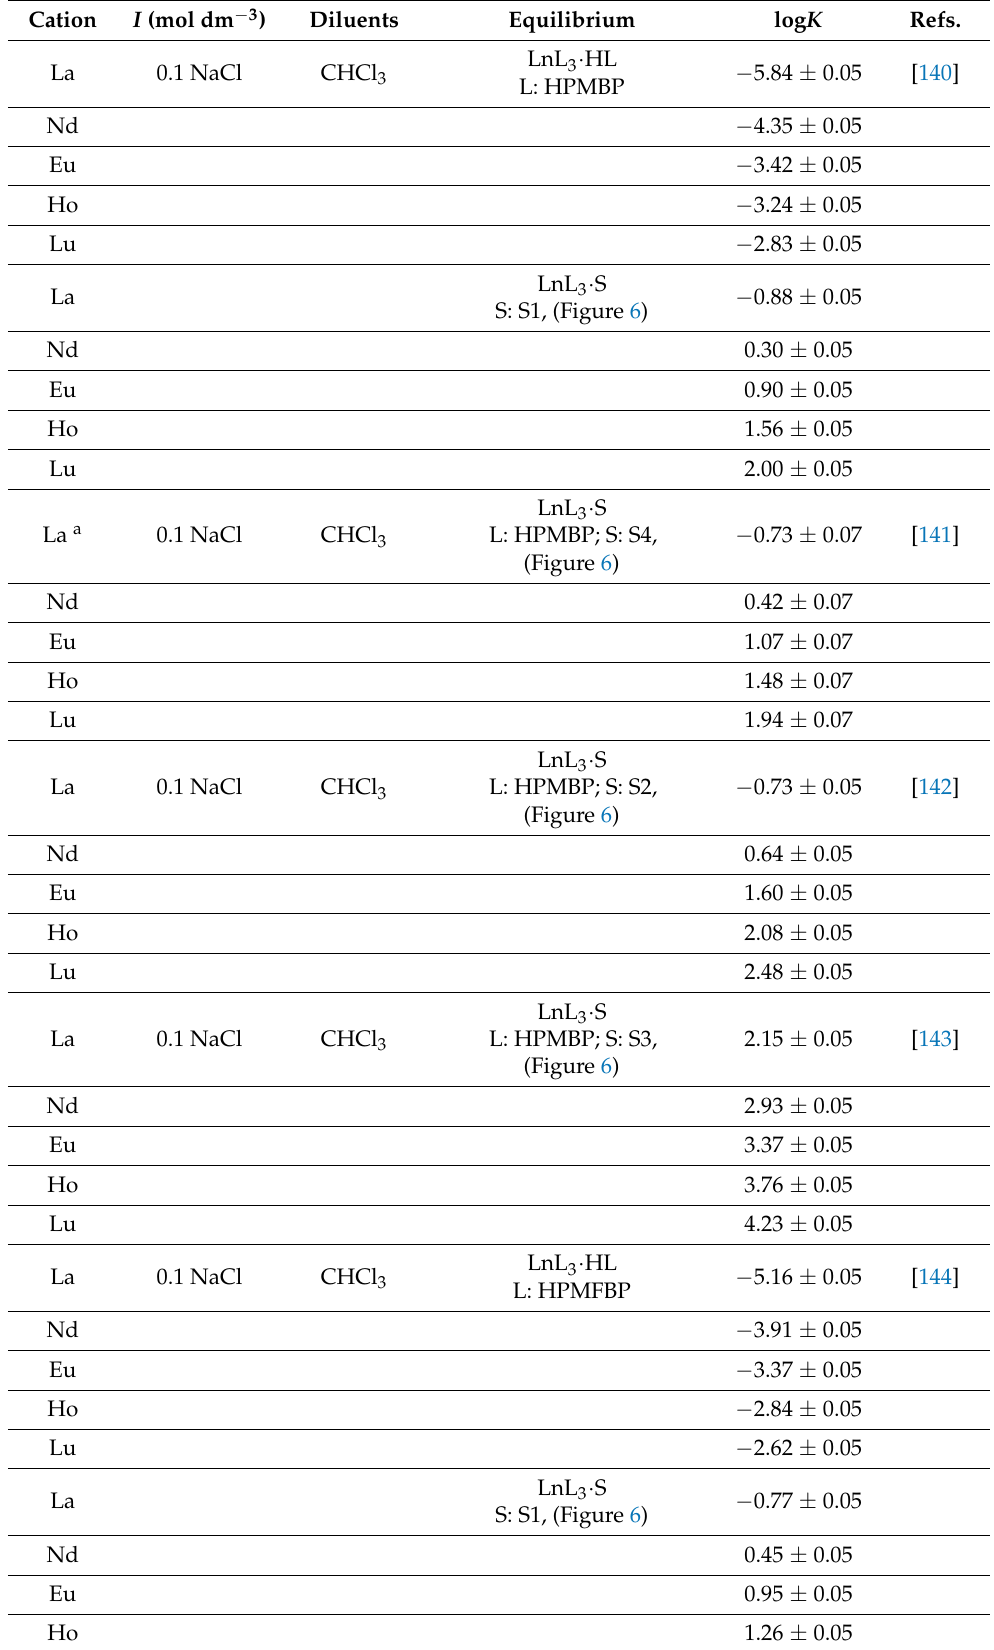
Table 6. Recommended data for the synergistic solvent systems of 4-acyl-pyrazolone and calixarenes.